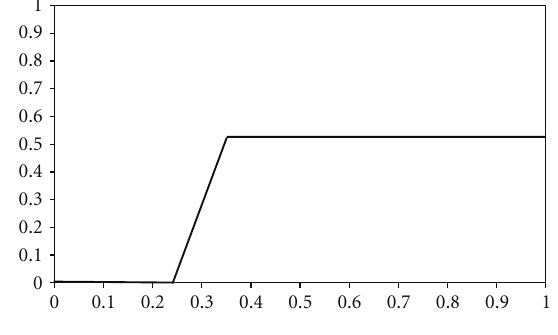
Figure 6: Obtaining each rule conclusion.